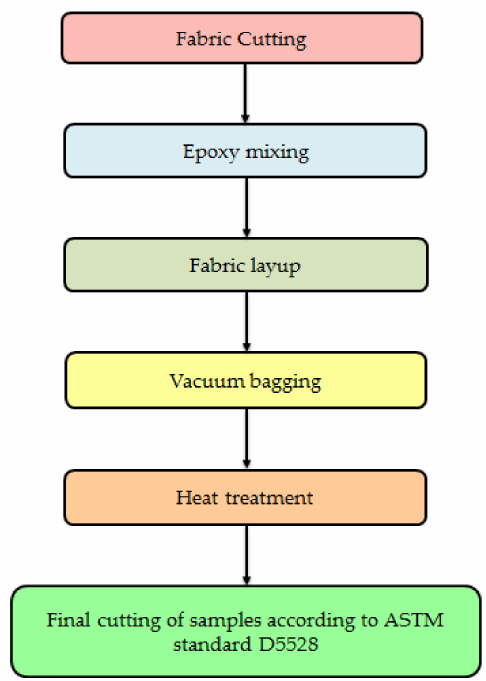
Figure 1. Fabrication steps.